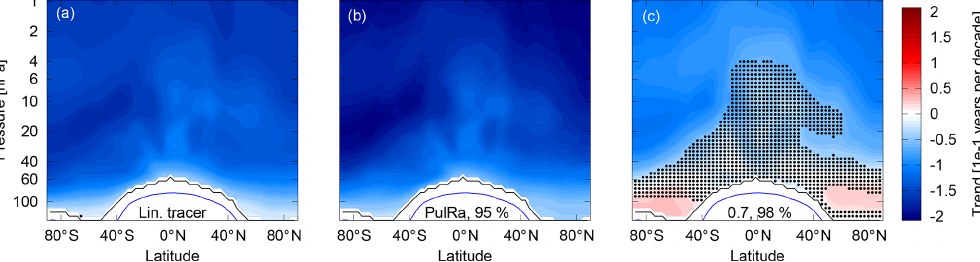
Figure 10. Trends of mean AoA from 1975 to 2011 (a) derived from a linear tracer, (b) from SF 6 for the ratio of moments from the extended pulse spectra and 95% fraction of input and (c) from SF 6 for 0.7-year ratio of moments and 98% fraction of input. White areas are the areas that cannot be analysed for a trend and black stippling shows insignificance of the trend from zero on the 95% confidence level using a t